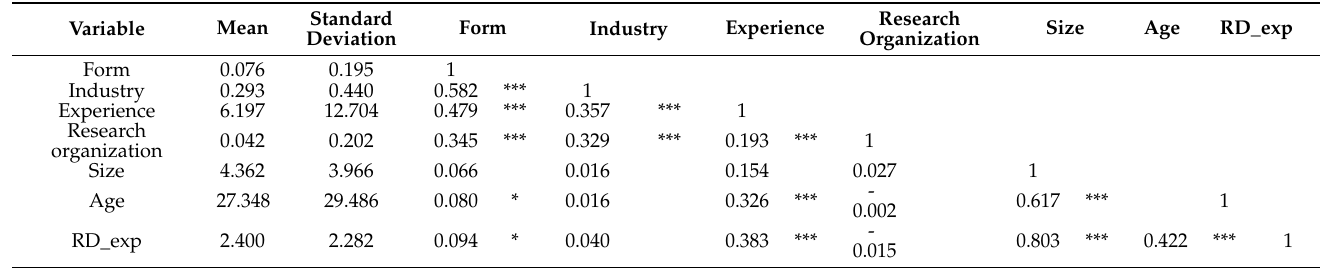
Table 3. Subject characteristics and correlations among variables.